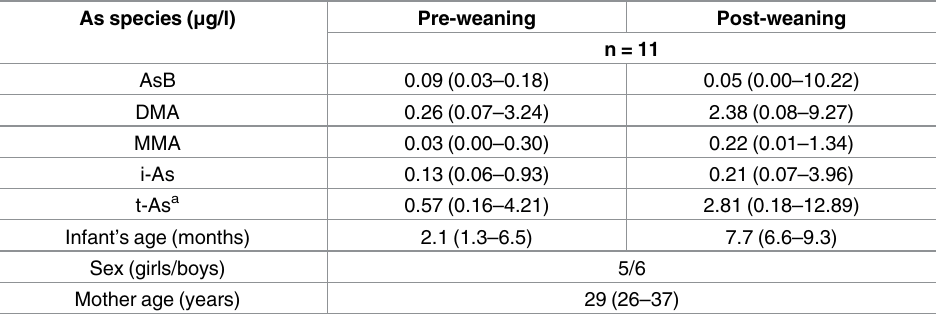
Table 2. Urinary As speciation concentration ( μ g/l) and selected characteristics of the study popula- tion in paired urine samples pre- and post-weaning. As species ( μ